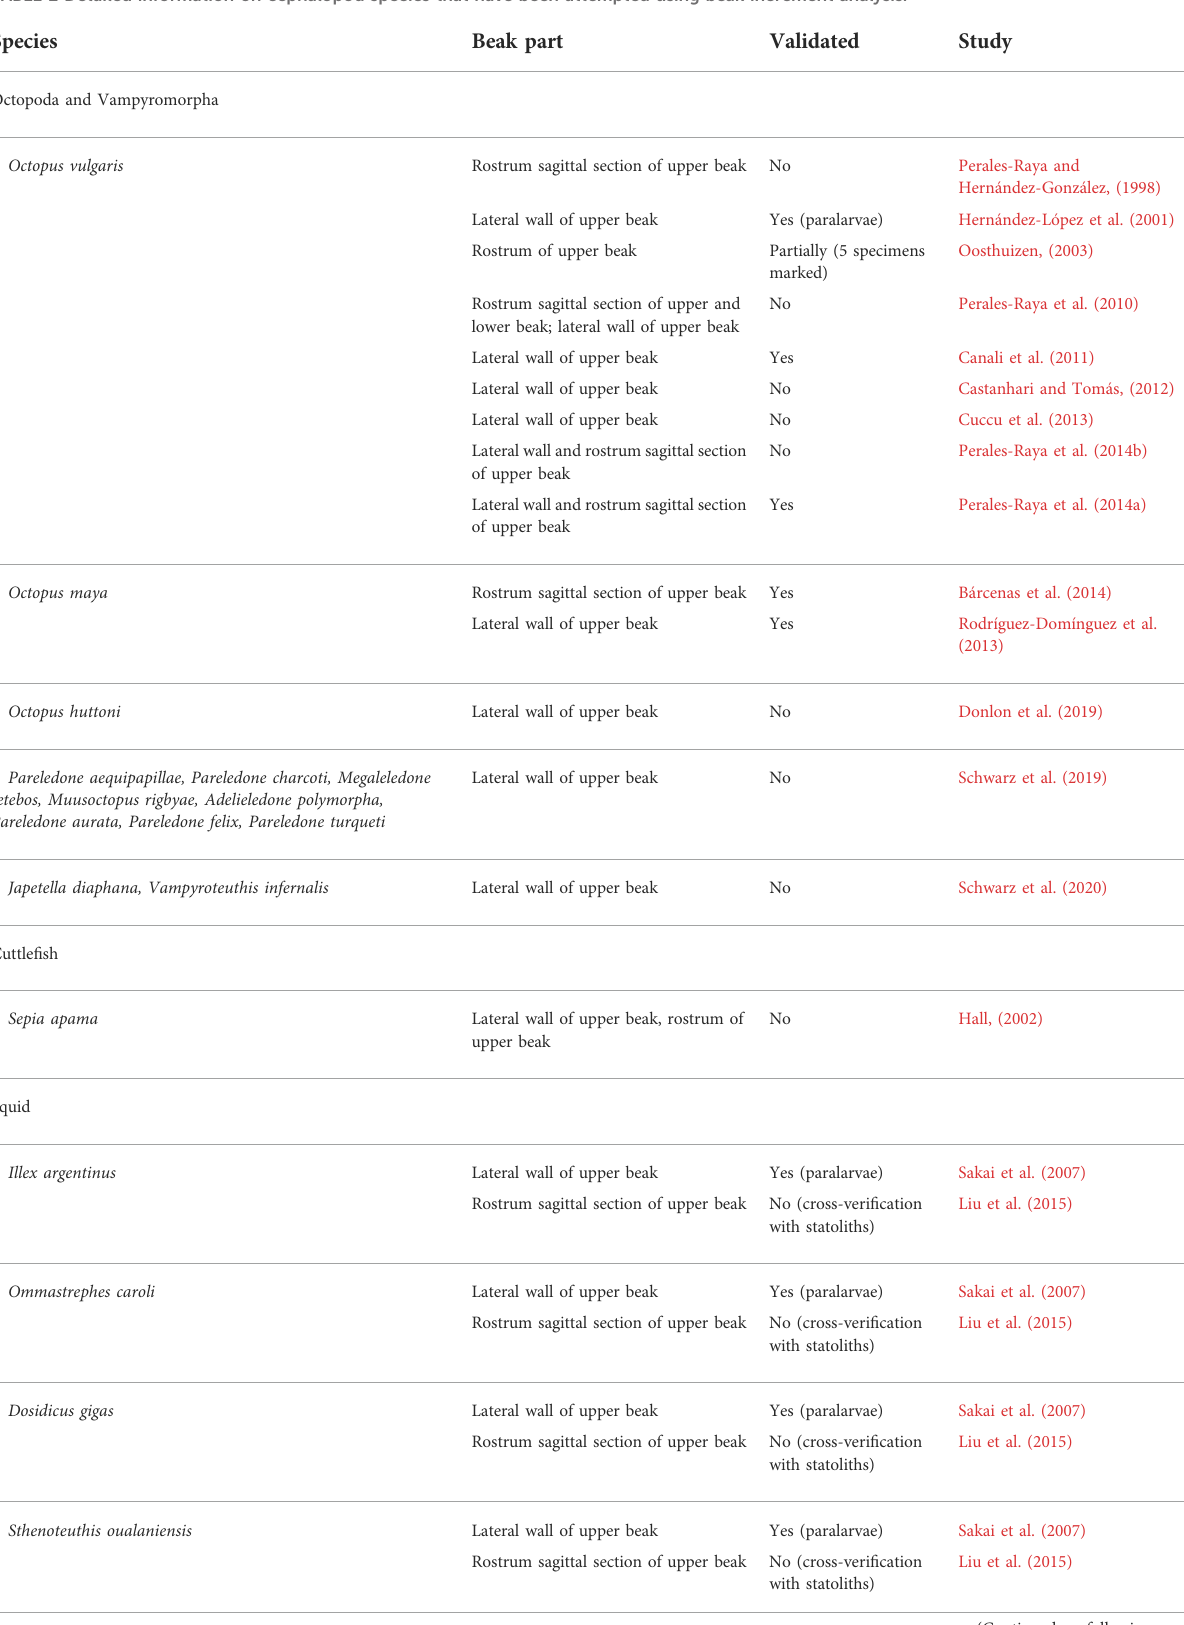
TABLE 2 Detailed information on cephalopod species that have been attempted using beak increment